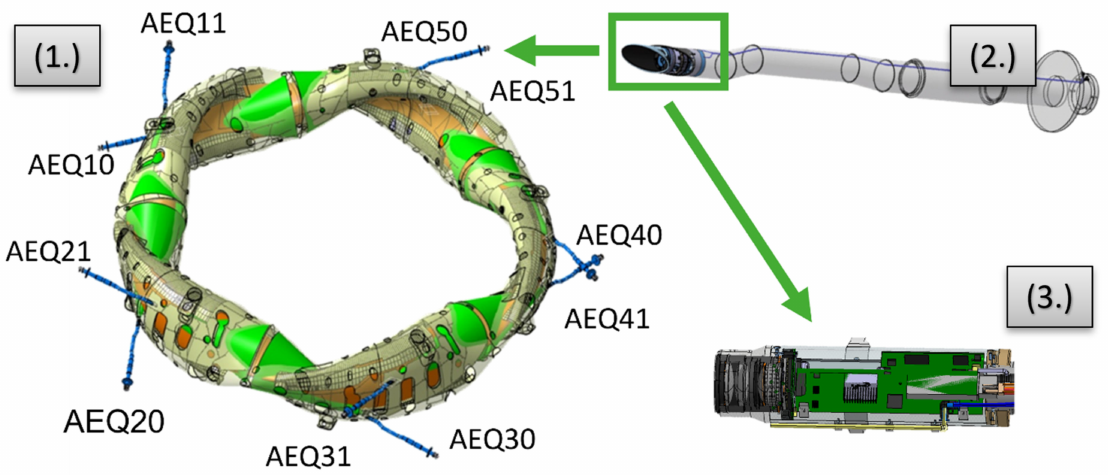
Figure 2. ( 1 .) Overview of the visible video diagnostics ports in the vessel. ( 2 .) One of the AEQ ports is connected with a flexible tube. ( 3 .) A camera head containing only the most important electronics and